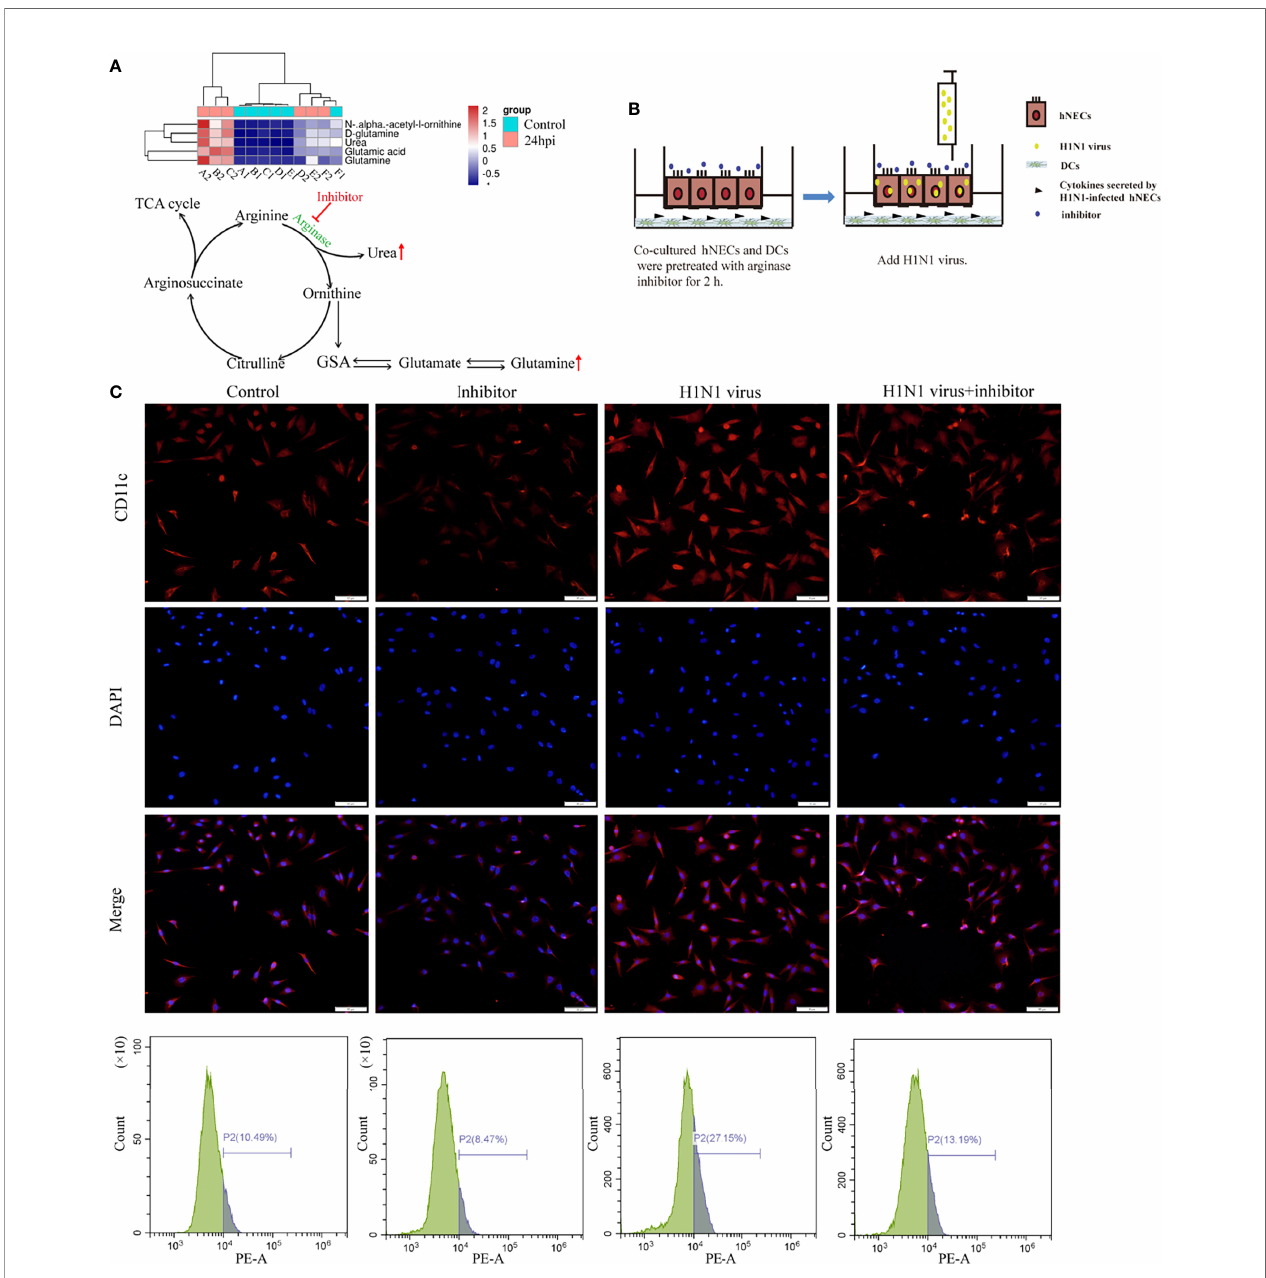
FIGURE 7 | Arginase inhibitor 1 can reduce DCs cell recruitment induced by H1N1 virus-infected hNECs cells. (A) Differentially expressed metabolites in the arginine biosynthesis signaling pathway and the pattern map of the signaling pathway. (B) Before H1N1 virus infection of hNECs and DCs co-culture system, arginase inhibitor was added for pretreatment for 2h, and then virus infection was carried out. (C) H1N1 virus infection in the co-culture system for 24h, the recruitment of DCs was detected by immuno fl uorescence, the red fl uorescence represents CD11c-speci fi c staining, and the blue fl uorescence represents nuclear staining (DAPI), bar=50um. The peak graph on the right is the detection of CD11c red fl uorescence intensity by fl ow